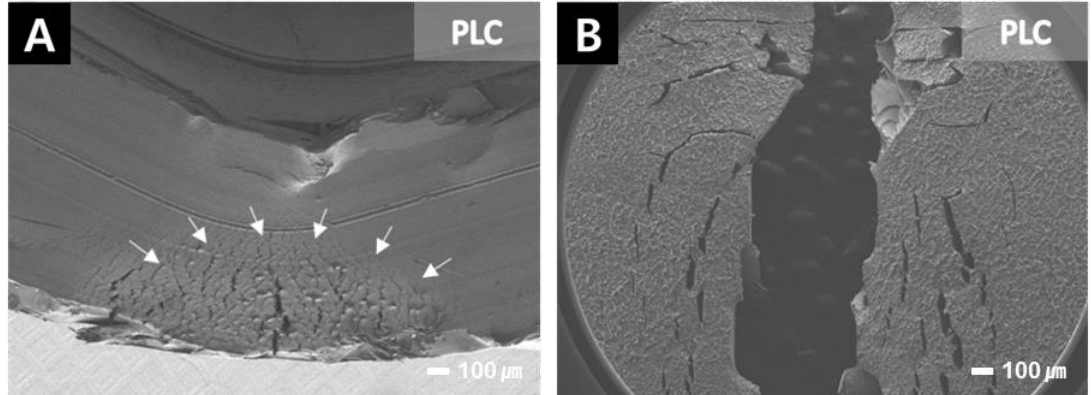
Figure 10. SEM images of the PLC specimen after its flexural strength test at 30-times magnification. The PLC specimens were high elasticity did not break easily. Many fatigue crack lines were observed on the fracture surface. The arrows in panel indicate the fatigue crack lines. ( A ) Unbroken PLC specimen after fracture test, and ( B ) top side of a broken specimen after the flexural strength